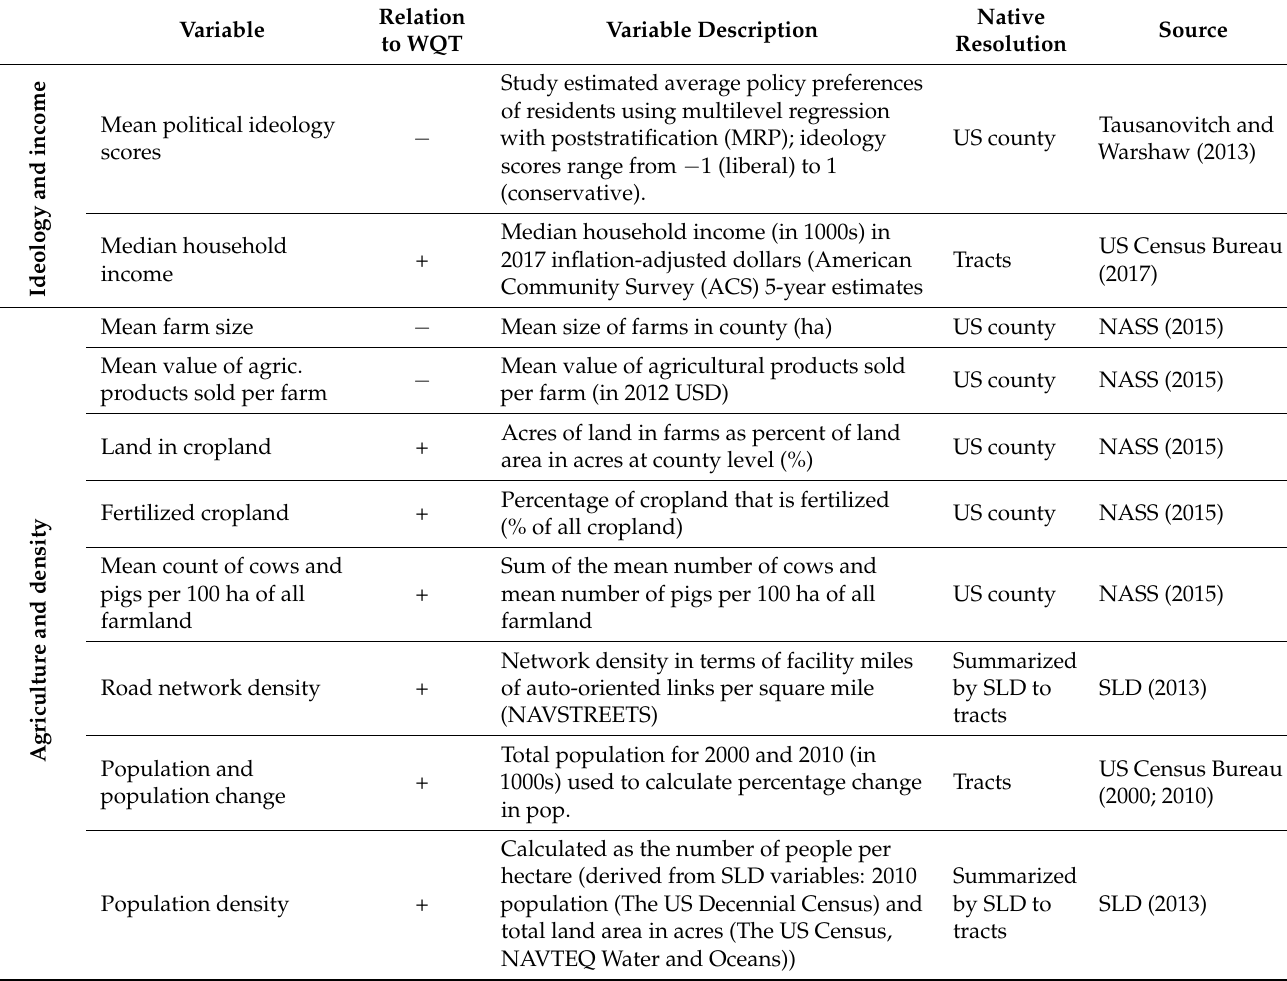
Table 2. Covariate data, data sources, and hypothesized relationships with water quality trading program extent and prevalence. SLD indicates the USEPA Smart Location Database [55]. NASS indicates the USDA’s National Agricultural Statistics Service [56]. “Tracts” indicate US Census tract boundaries